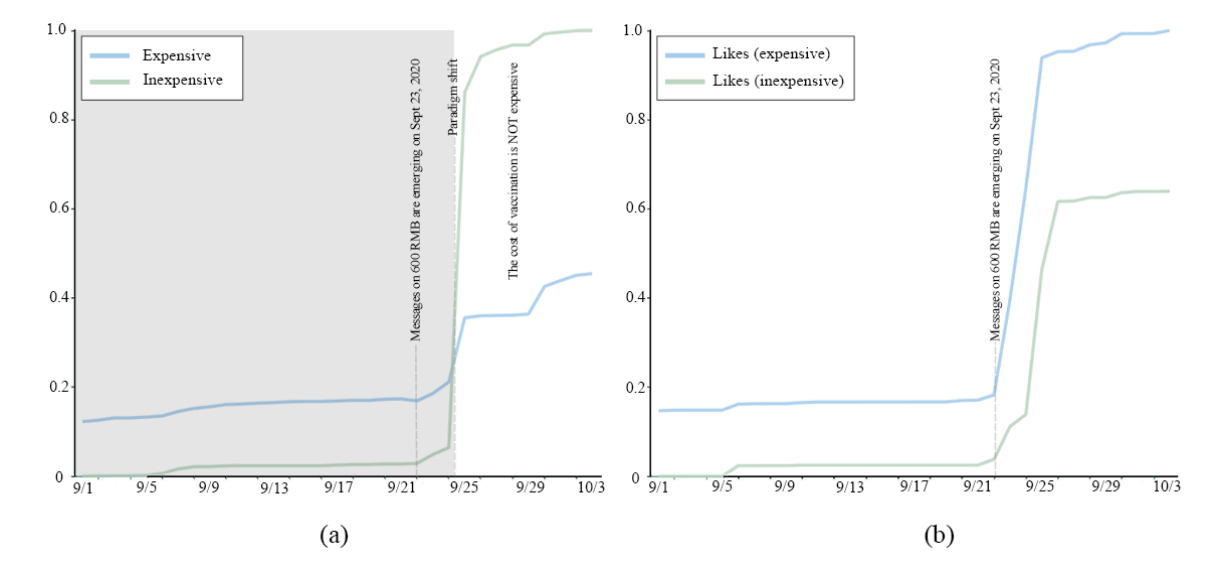
Figure 4. The paradigm shift in price